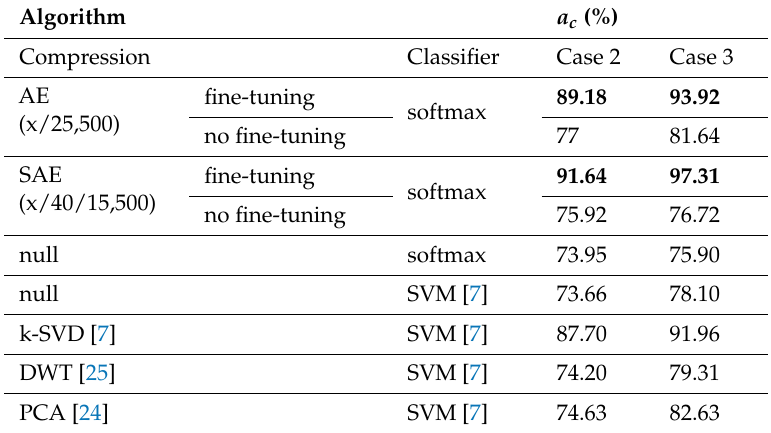
Table 5. The classification accuracy of different